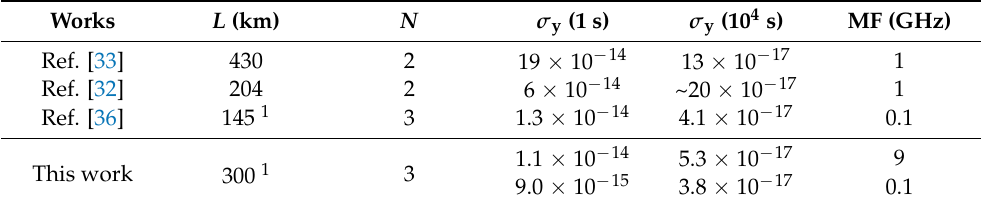
Table 1. Characteristics of cascaded fiber-based microwave frequency transfer compared with previous studies. L : length of fiber link; N : numbers of single-span; σ y (1 s): fractional instability at 1